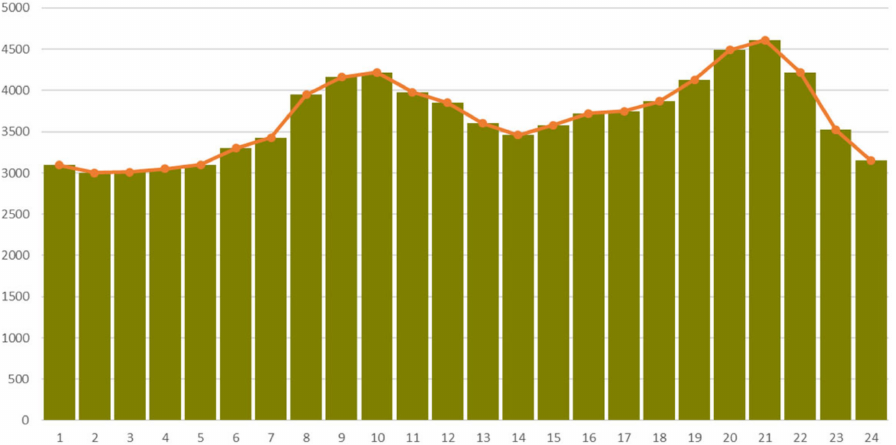
Figure 2. Total energy consumption value (kWh) over a standard day.